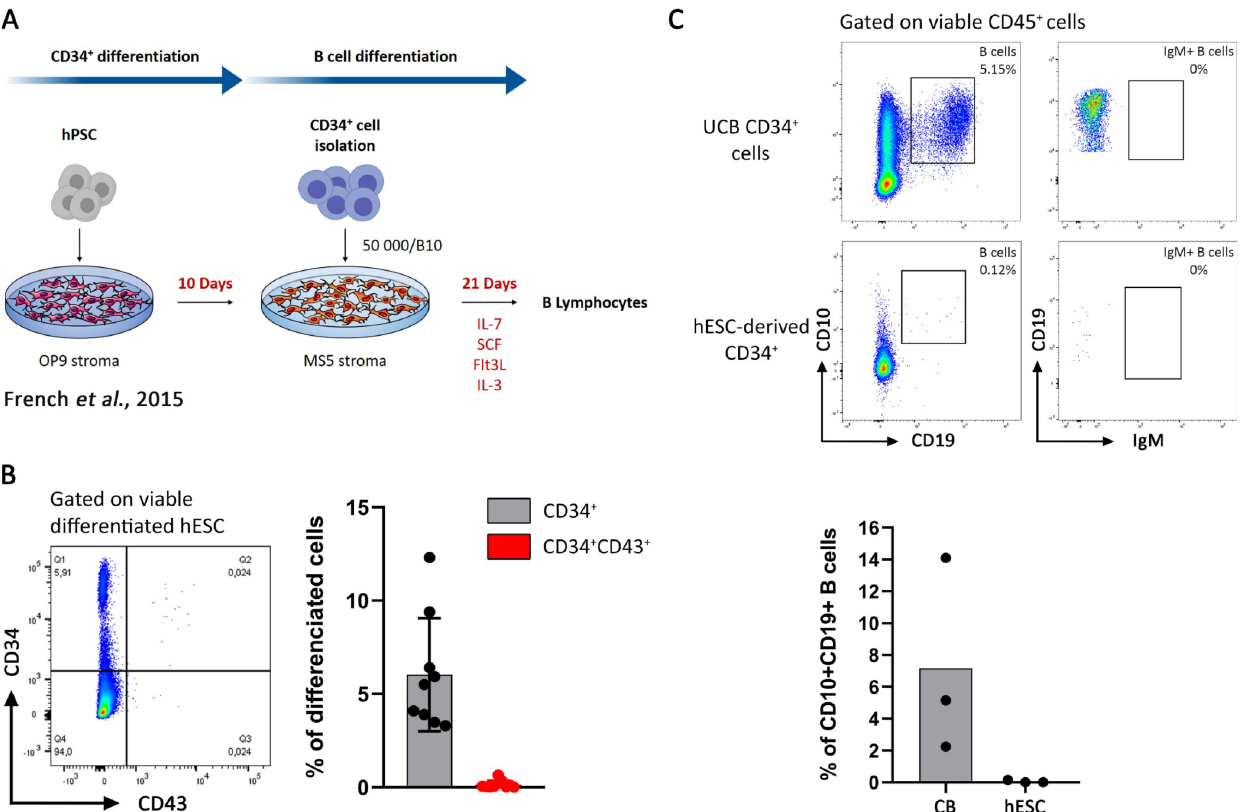
Fig 1. CD34 + generation from hPSC without cytokines and their low potential in B cell differentiation. (A) Protocol of hPSC differentiation into B cells as previously described [14]. (B) CD34 + differentiation from H9 hESC onto OP9 stroma at Day 10. CD34/CD43 expression analyzed by flow cytometry on viable differentiated hESC is shown in the left as a dot plot from one representative experiment and the proportion of CD34 + cells (in black) and CD34 + CD43 + (in red) are shown on the right panel, n = 9 experiments. (C) B cells differentiation at Day 21 from UCB CD34 + cells (Upper panel) and CD34 + -derived hESC (middle panel). CD10 + CD19 + B cells proportion and their IgM expression was analyzed on viable CD45 + cells, dot plot from one representative experiment is shown. Histogram of CD10 + CD19 + B cells proportion is presented in the lower panel (n = 3 experiments from both UCB CD34 + cells and hESC-derived CD34 +